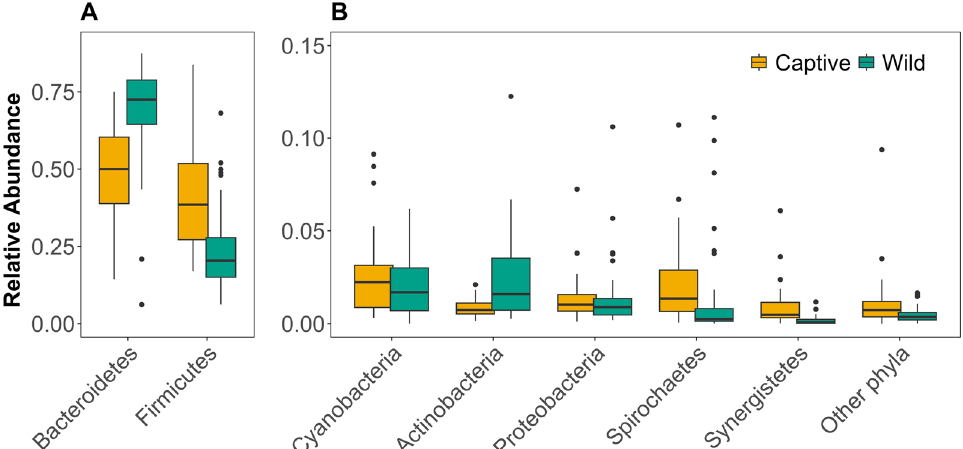
Fig. 3 Boxplots of relative abundances for each sample and the seven phyla with 100% prevalence within wild and captive faecal samples from the Damaraland mole-rat. A The two dominating phyla, Firmicutes and Bacteroidetes. B Cyanobacteria, Actinobacteria, Proteobacteria, Spirochaetes and Synergistetes and other phyla, representing the sum of relative abundance of phyla not represented in all samples. Yellow boxes represent samples from captive individuals and blue-green boxes samples from wild individuals. Note the different y-axis scaling in the two panels